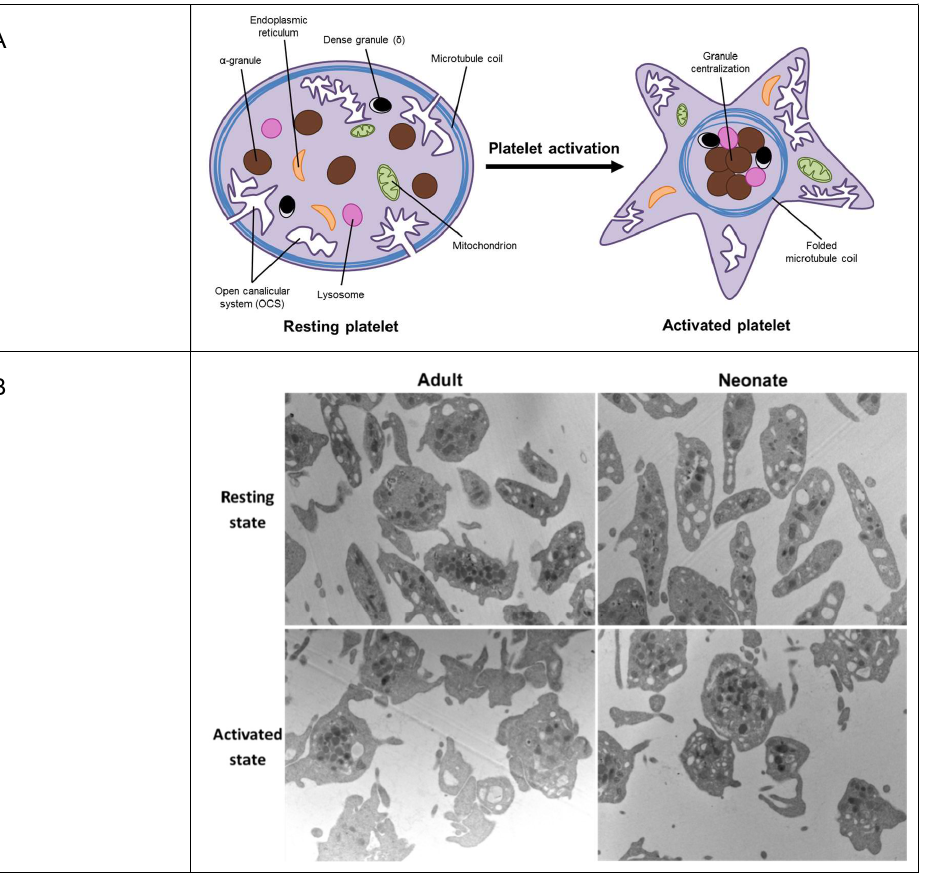
Figure 3. Platelets under resting and stimulation conditions. ( A ) A schematic representation of granule reorganization during platelet activation. ( B ) Neonatal and adult representative platelet ultrastructure images, obtained by electron microscope with a magnification of 9700×. Granule centralization, before and after stimulation, was quantified in 50 sections per sample (3 samples per group), and per state (basal and stimulated). Statistical analysis showed differences in granule distance to the centroid in adult basal platelets as compared to 10 µM Thrombin receptor agonist peptide-6 (TRAP)-stimulated adult platelets ( p < 0.01). No differences were found, by contrast, between basal and stimulated neonatal platelets or between quiescent adult and neonatal platelets. Granule centralization was measured using the Leica QWin Pro v3 Software (Leica Microsystems).